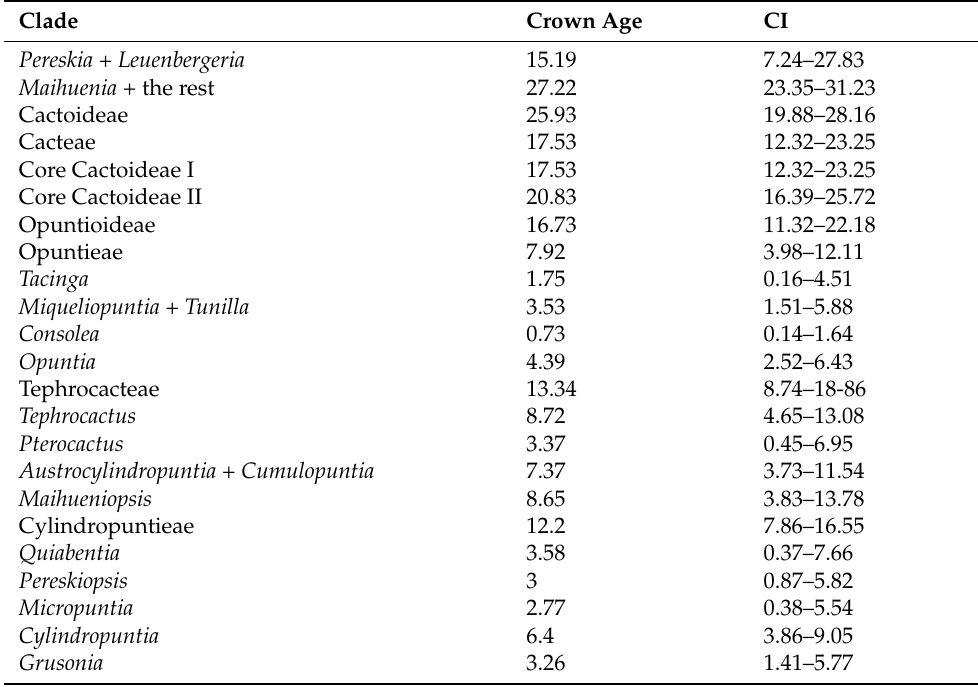
Table 1. Crown ages and confidence intervals from our BEAST